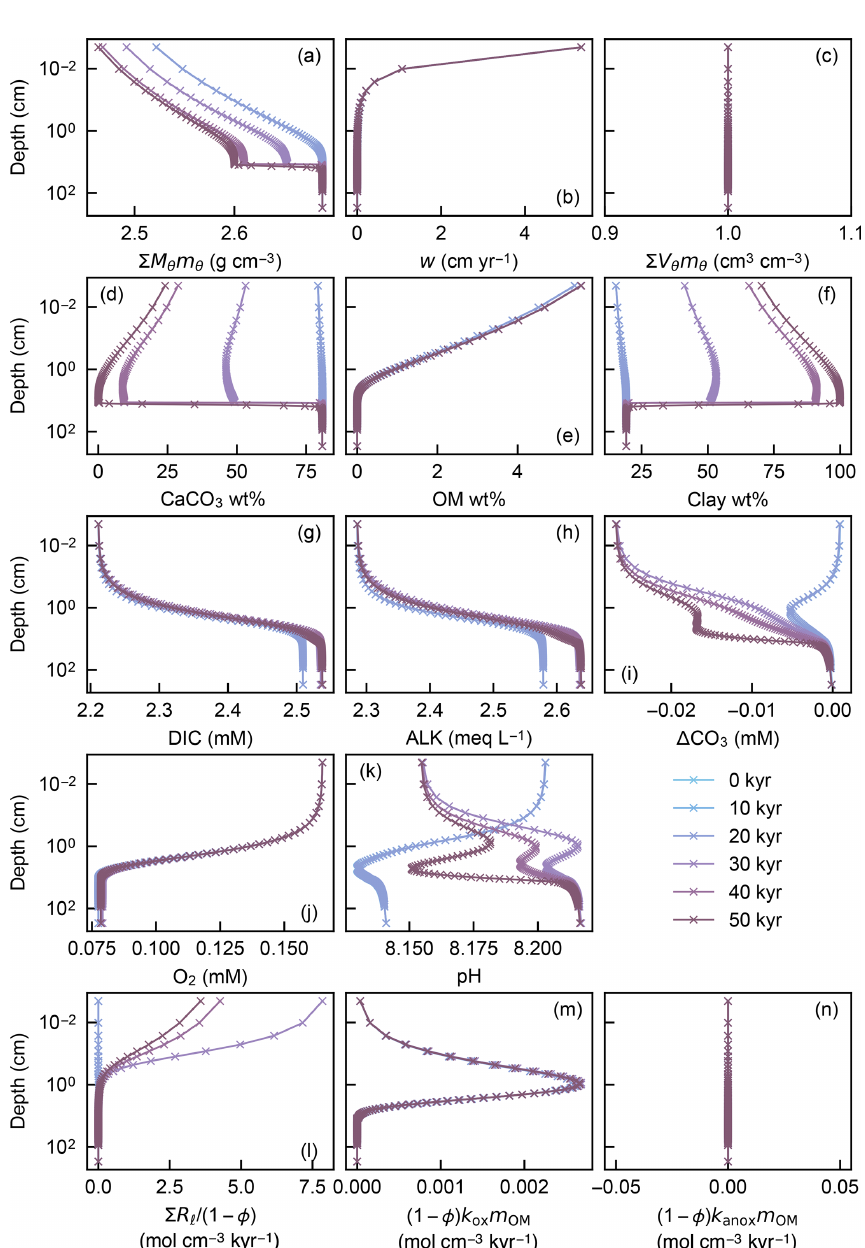
Figure 7. Depth profiles of the density (a) and volume fraction (c) of solid sediment, burial velocity (b) , weight fractions of bulk CaCO 3 (d) , organic matter (e) and nonreactive detrital materials (f) in solid sediment, porewater concentrations of total dissolved CO 2 species (g) , carbonate alkalinity (h) and oxygen (j) , deviation of porewater carbonate concentration from that in equilibrium with CaCO 3 (i) , porewater pH (k) , dissolution rate of CaCO 3 (l) , and decomposition rate of organic matter in the oxic (m) and anoxic (n) zone of sediment, as a function of time. The boundary conditions of the model change with time as in dissolution experiment 2 (Sect. 3.2.2, Fig. 12). The calculations assume four classes of CaCO 3 particles and Fickian mixing for bioturbation. Illustrated are the temporal evolutions of the depth profiles which are initially at steady state at 3.5km of water depth but perturbed by water depth change to 5.0km between 5 and